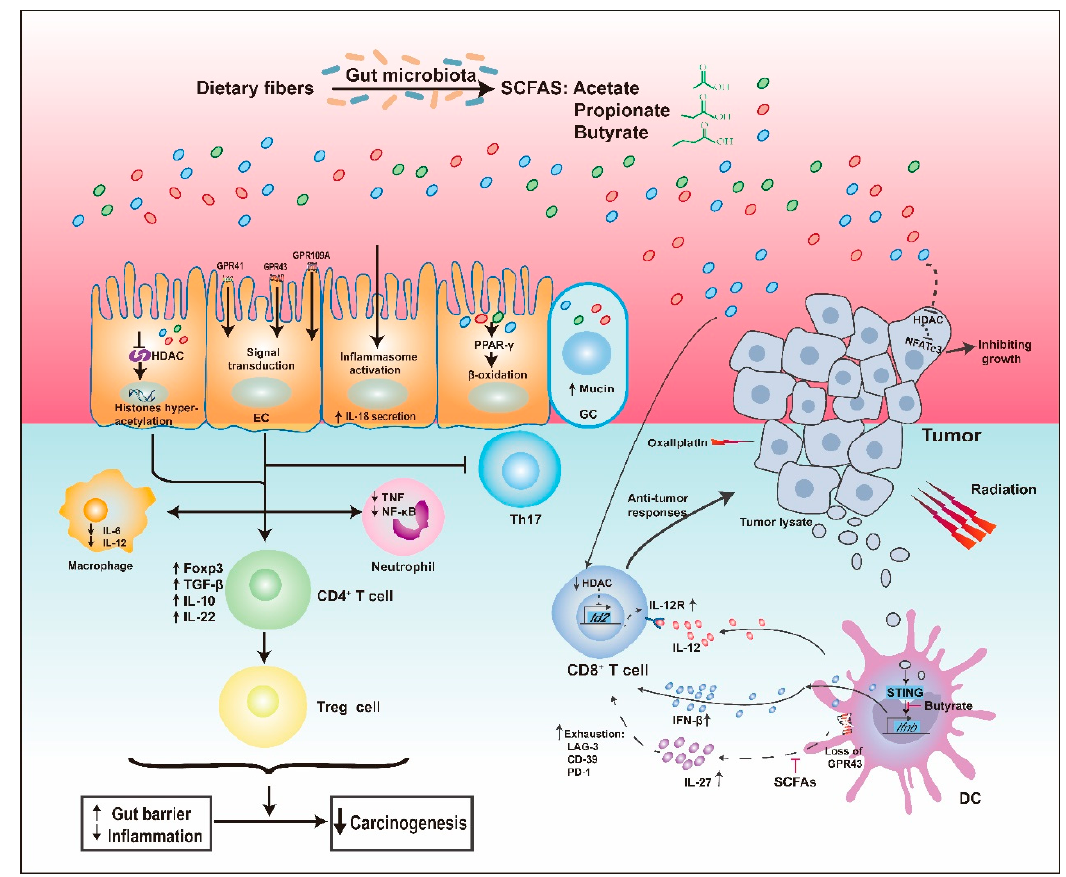
Figure 1. SCFAs and their Immunomodulatory Functions. SCFAs, mainly consisting of acetate, propionate, and butyrate, act as histone deacetylase (HDAC) inhibitors and ligands of G-protein-coupled receptors (GPCRs), leading to the expansion and differentiation of FOXP3+ regulatory T (Treg) cells, accompanied by upregulation of immunosuppressive IL-10 and transforming growth factor-beta (TGF- β ), downregulation of proinflammatory cytokines in macrophages and neutrophils, and inhibition of differentiation towards T helper type 17 (Th17) cells, thereby suppressing inflammation and carcinogenesis. Significantly, SCFAs, especially butyrate, could influence the antitumor responses of CD8+ T cells by regulating signaling pathways in dendritic cells (DC), involving IL-12, IL-27, and IFN- β , which also have an impact on the combination therapy of tumor. Additionally, SCFAs directly inhibited tumors by inhibiting HDAC. Regarding their other protective properties, SCFAs could increase the secretion of mucin, enhance epithelial integrity by activating inflammasome, and activate the peroxisome proliferator-activated receptor- γ (PPAR- γ ) pathway, which maintains anaerobic conditions. See the text for details. EC, epithelial cell; GC, goblet cell; NF- κ B, nuclear factor κ B; IFN- β , interferon β